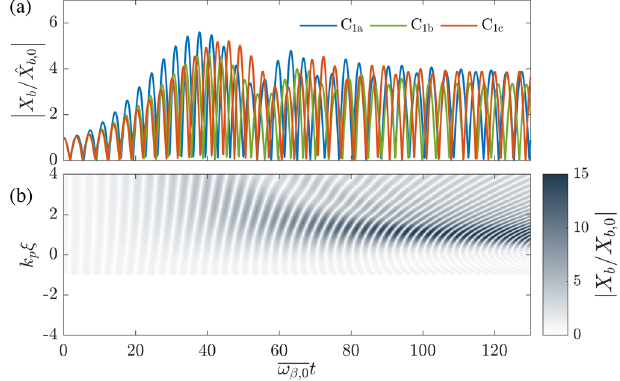
FIG. 3. (a) Evolution of beam centroid at the beam tails (at k ξ ¼ 4 . 0 ) for a beam with 5 GeVand 5 kA, case C p beam with 10 GeV and 10 kA, case C 1 with 25 GeV and 23 kA, case C 1 simulations. (b) Centroid evolution in t and along ξ for case C 1 as retrieved from a PIC simulation.